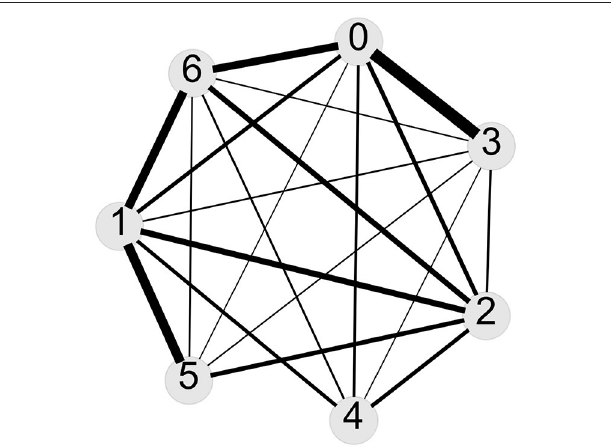
FIGURE 3 | A representation of the mismatch between topic model assignments and human coding. The edges between topics are weighted proportional to the number of posts that are co-assigned to the corresponding topics by the human coder and the